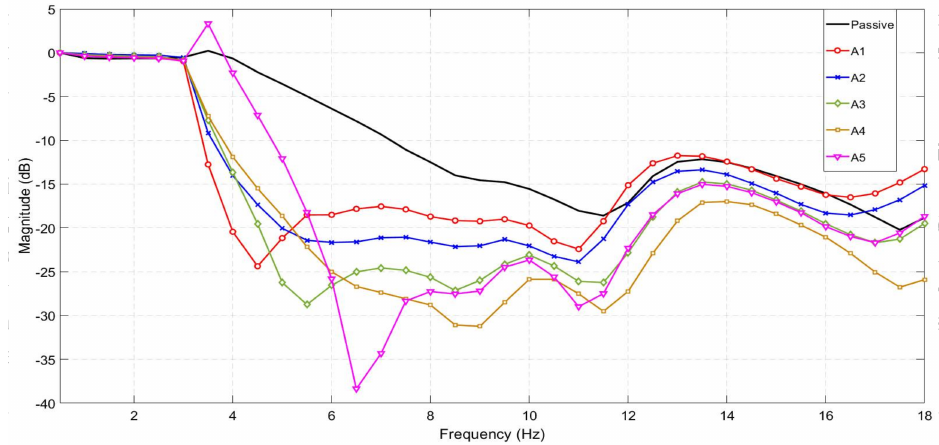
Figure 12. Measured seat acceleration transmissibilities of the passive and active